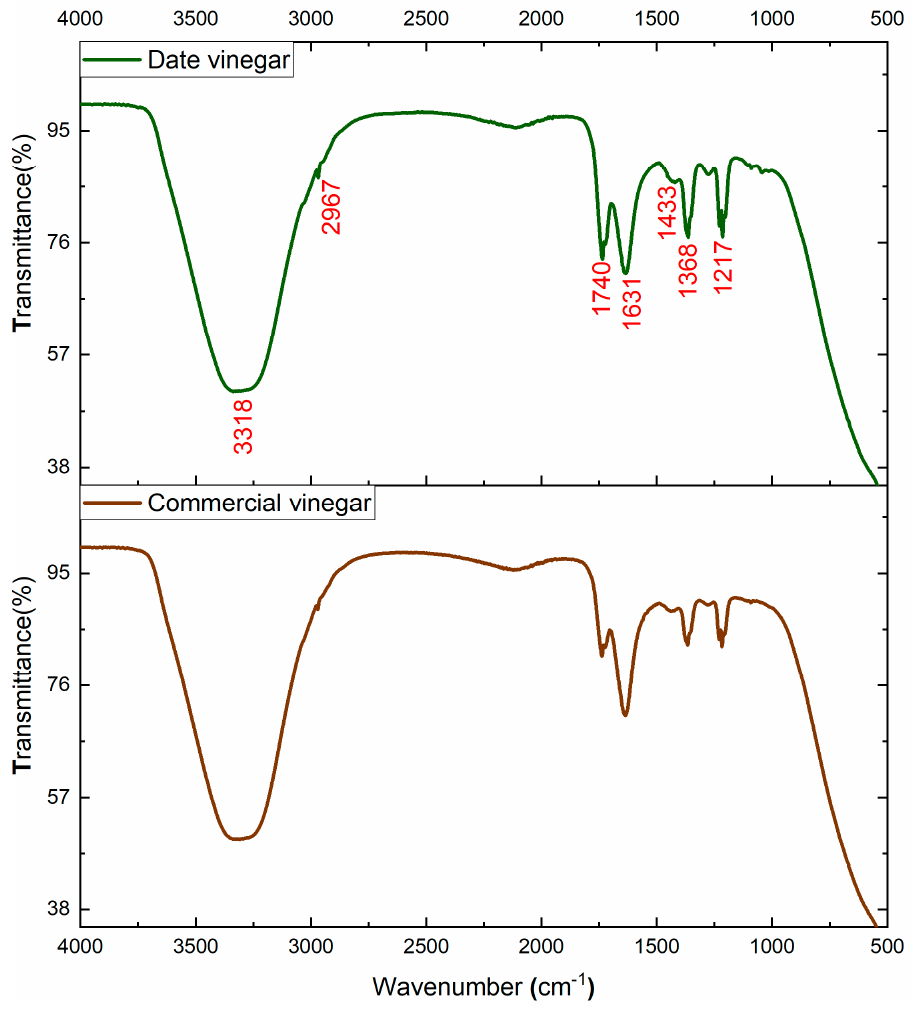
Figure 6. IR spectrum of date vinegar (V15) and commercial vinegar.